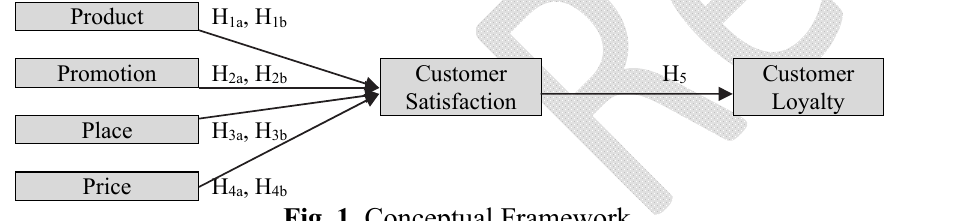
Fig. 1. Conceptual